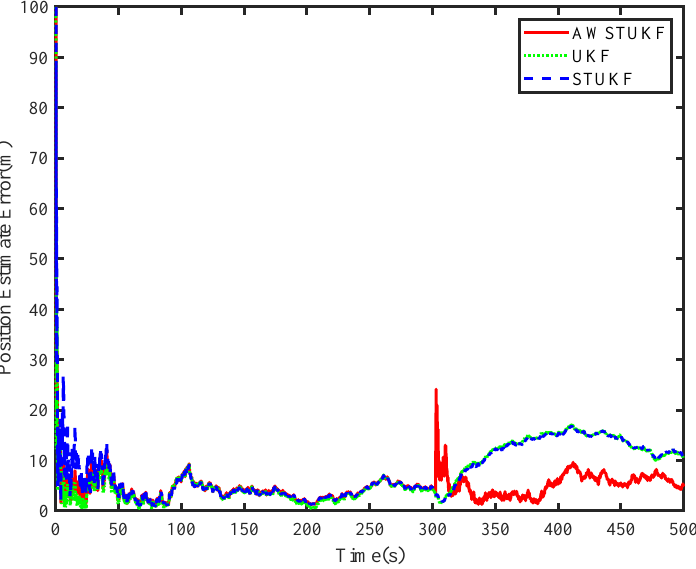
Figure 6. Velocity estimate errors of different methods.